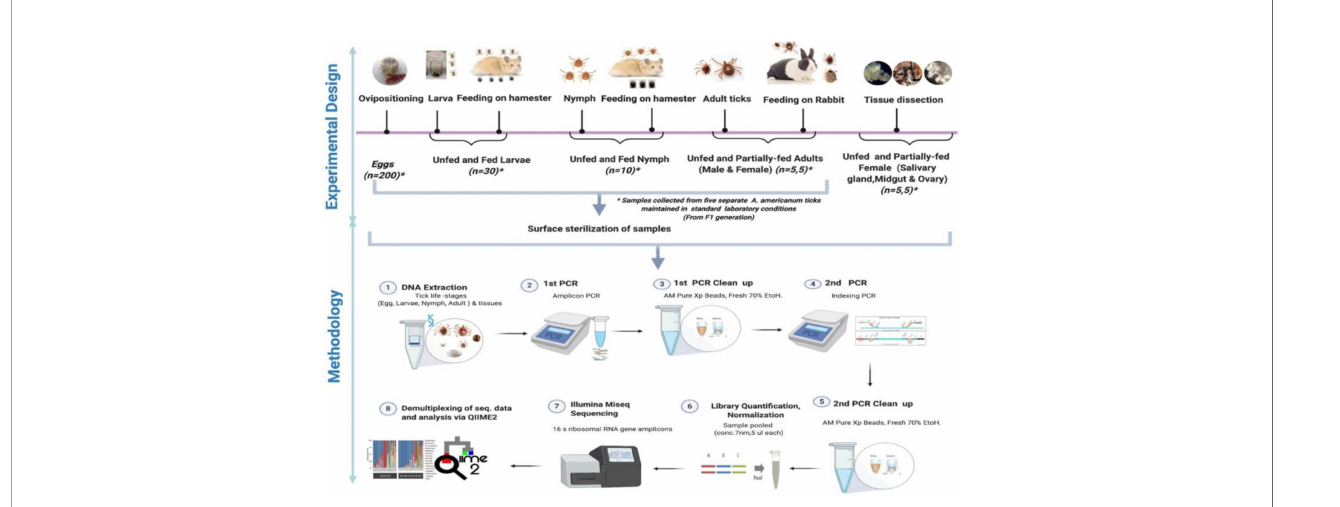
FIGURE 1 | Schematic work fl ow of microbiome study of the lone star tick for its life stages and